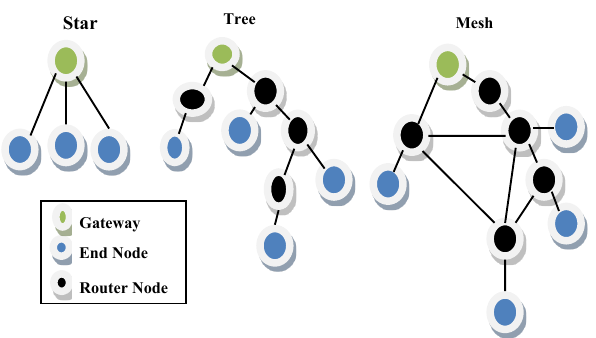
Figure 3. Different topologies supported by WSN Different types of WSNs can be deployed in different circumstances. Based on the deployment location, they are known as terrestrial WSN, underwater WSN, underground WSN, multimedia WSN and mobile WSN. Terrestrial WSN may have thousands of nodes effectively covering the target area and sending data to the base station. Underground WSN is costly, and it is used to capture data from beneath the earth. Water sensors work from within water bodies, while multimedia sensors can capture text, audio, video, and images for tracking and monitoring. Mobile WSN, on the other hand, provided mobility.